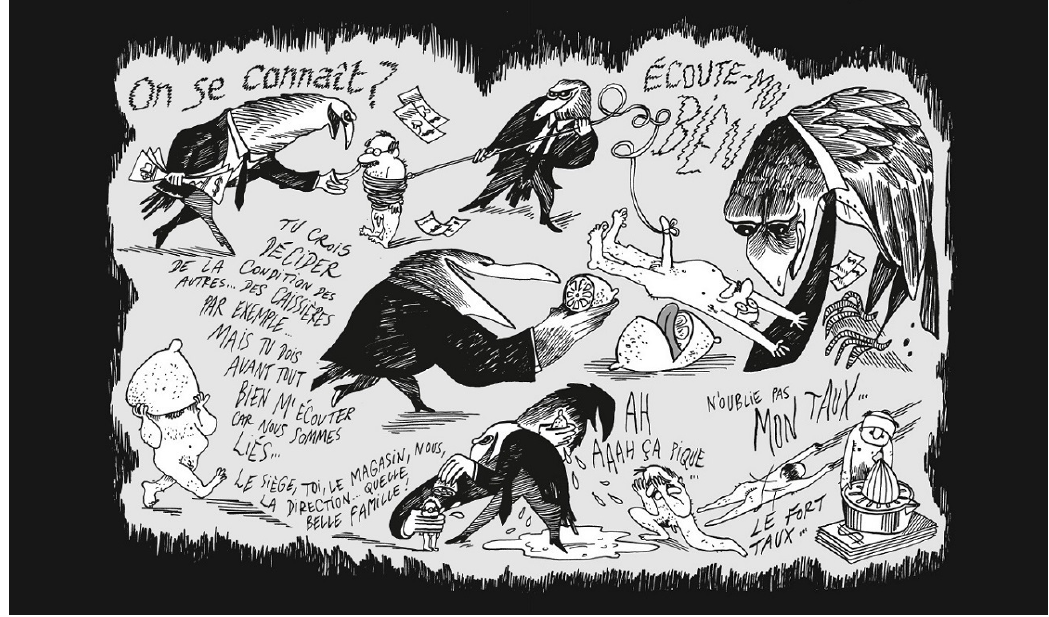
Figure 3: Encaisser, Benquet/Simon ©CASTERMAN (above